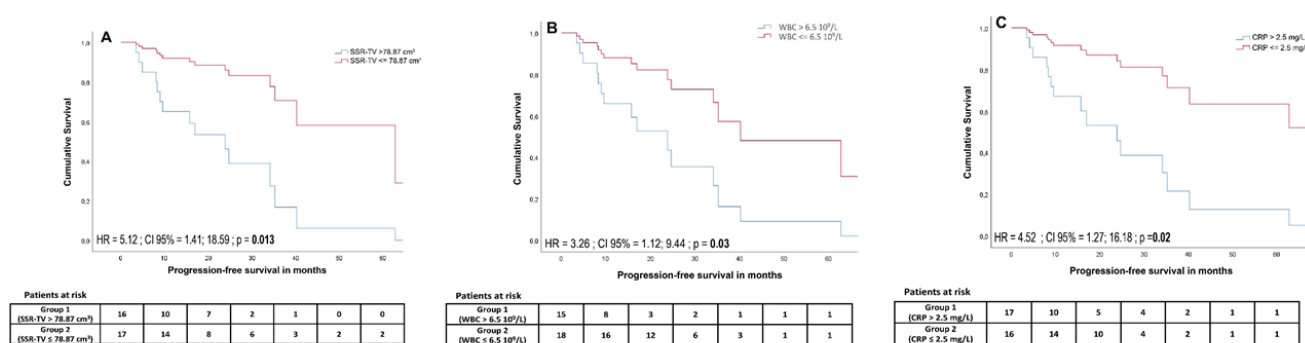
Figure 4. Cumulative survival curves for somatostatin receptor imaging-derived tumor volume (SSR TV) ( A ), white blood cell count (WBC) ( B ), and CRP ( C ) cut-offs estimated using a Cox proportional hazards regression model. High tumor volume, elevated white blood cell count, and elevated CRP levels were associated with significantly lower progression- free survival.